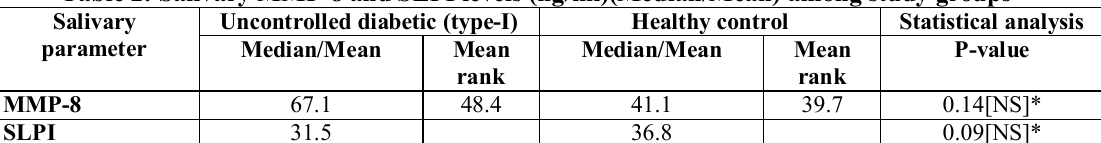
Table 2: Salivary MMP-8 and SLPI levels (ng/ml)(Median/Mean) among study groups Salivary